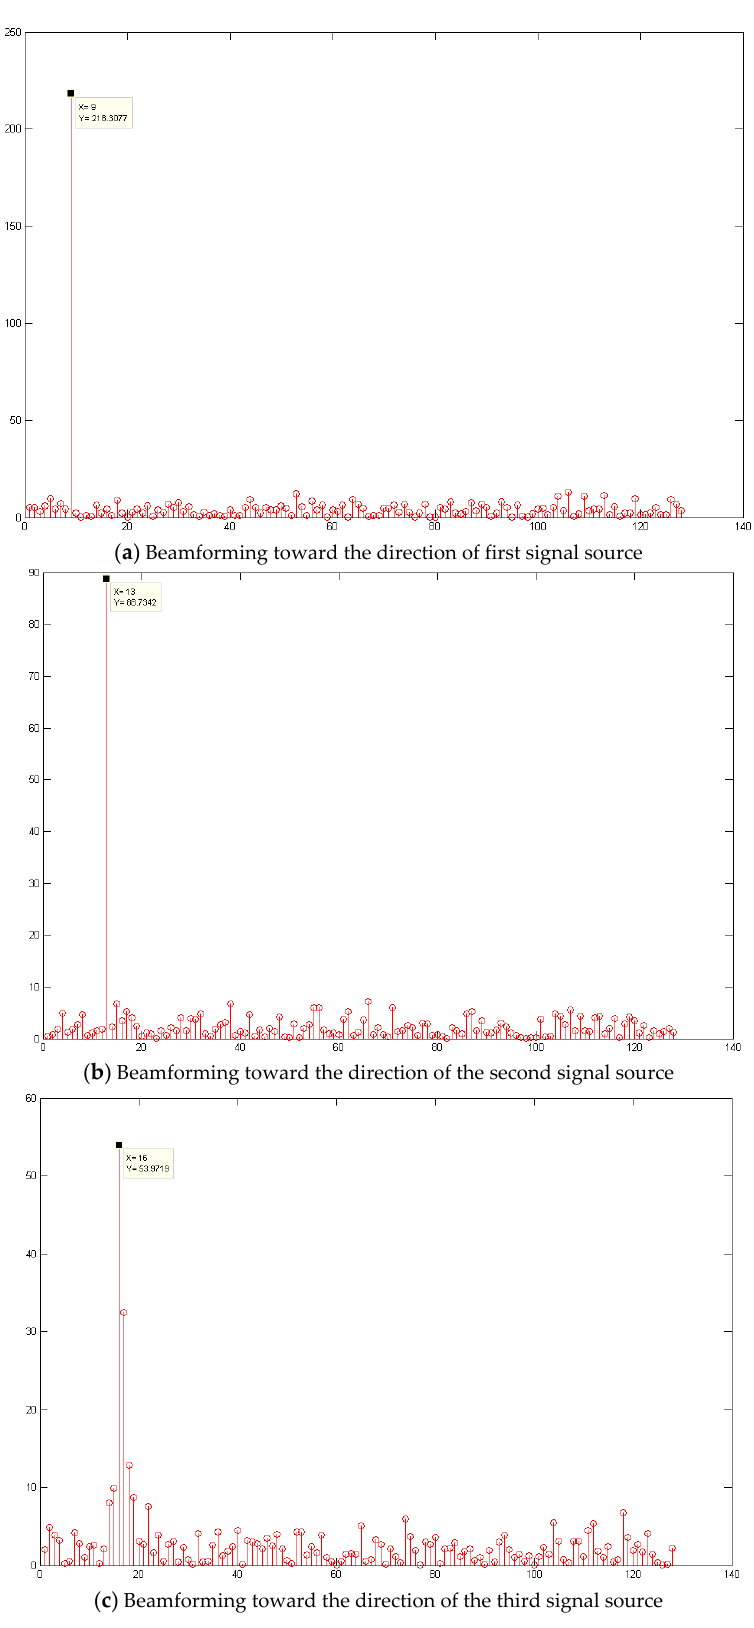
Figure 10. FFT spectrums of FMCW radar signal after applying Minimum Variance Distortionless Response (MVDR)